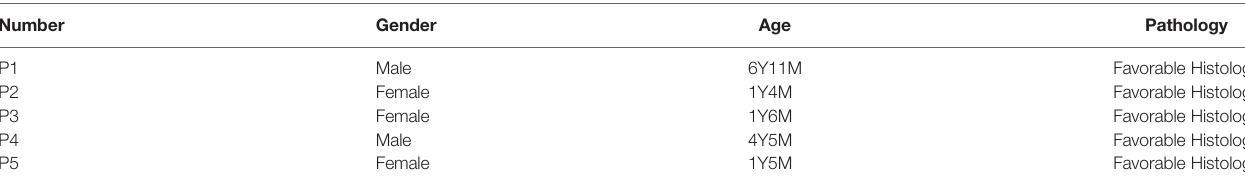
TABLE 1 | Demographics of WT cases for whole genome sequencing and RNA